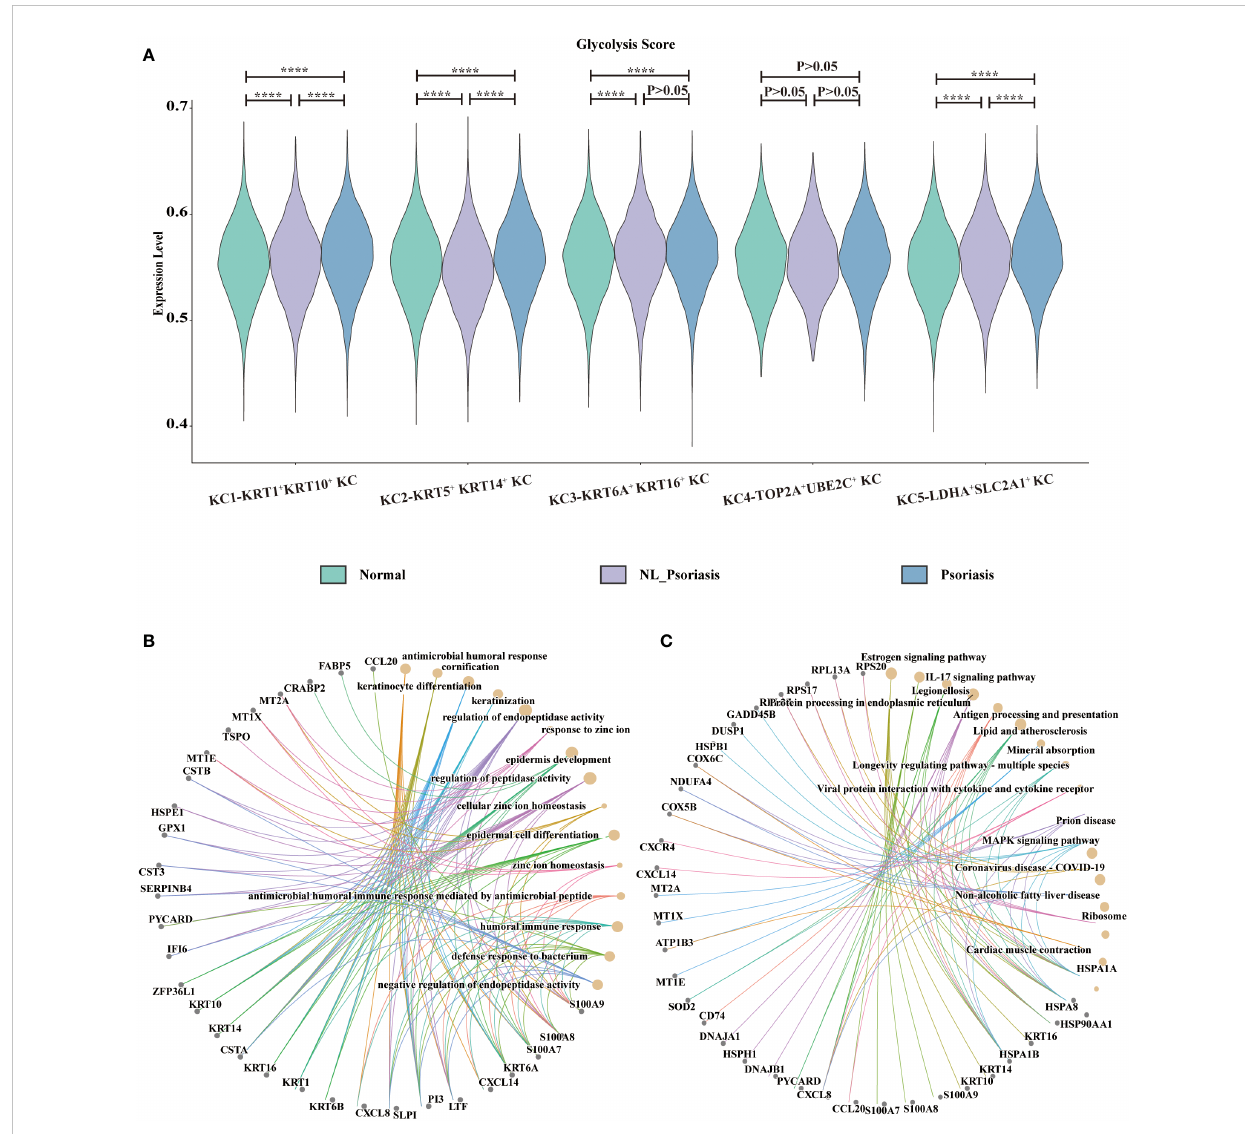
FIGURE 4 Glycolysis status in keratinocytes. (A) Display of glycolysis for subpopulations. Y-axis corresponds to glycolysis pathway activity. The X-axis represents KC population in normal skin, non-lesional and lesional psoriasis samples. (B, C) GO and KEGG enrichment analysis of top-100 differentially expressed genes between non-lesional phenotype and lesional phenotype. GO, gene ontology; KEGG, Kyoto Encyclopedia of Genes and Genomes